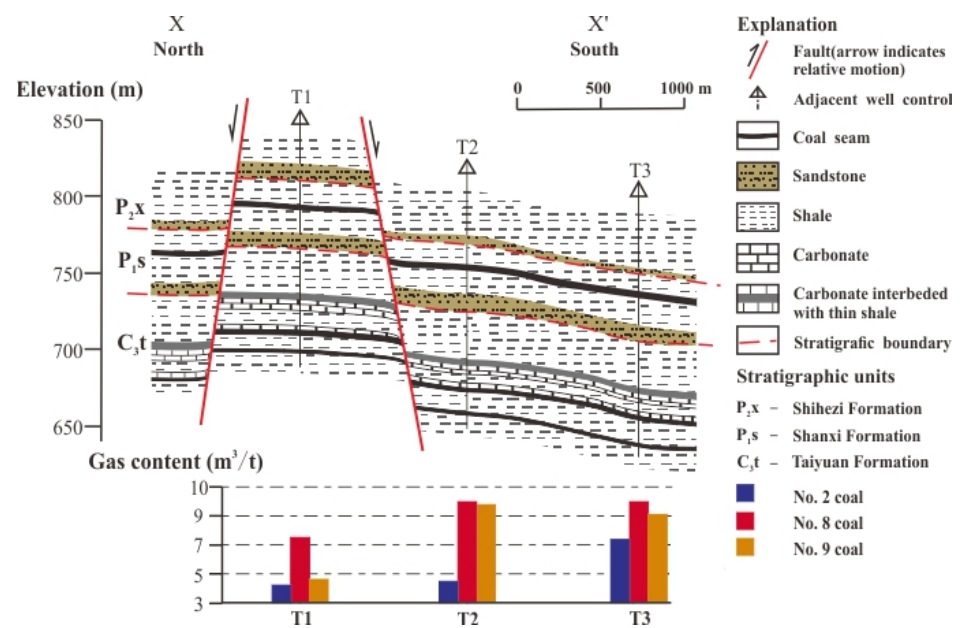
Figure 6. A N–S structural cross section of the normal faults. Gas content distribution refers to profile X–X’ in Figure 1.